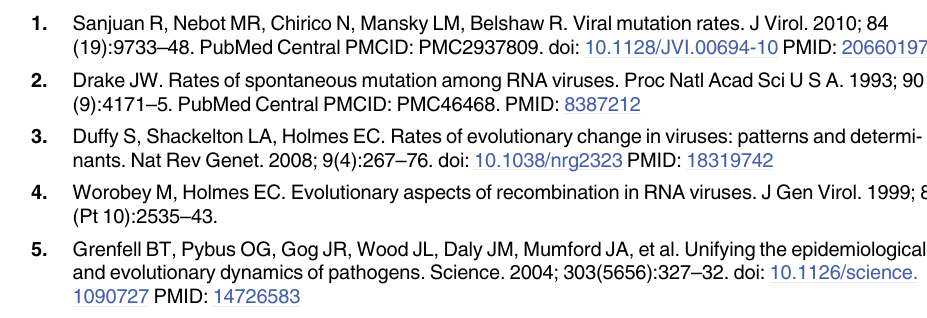
S3 Table. Norovirus ORF2 sequences used in the construction of trees representing the clustering of immunotypes. S4 Table. Sequences of GII.6, GII.12 and GII.17 noroviruses used in this study.